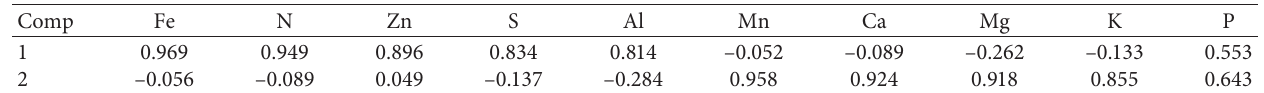
Table 6: Rotated component